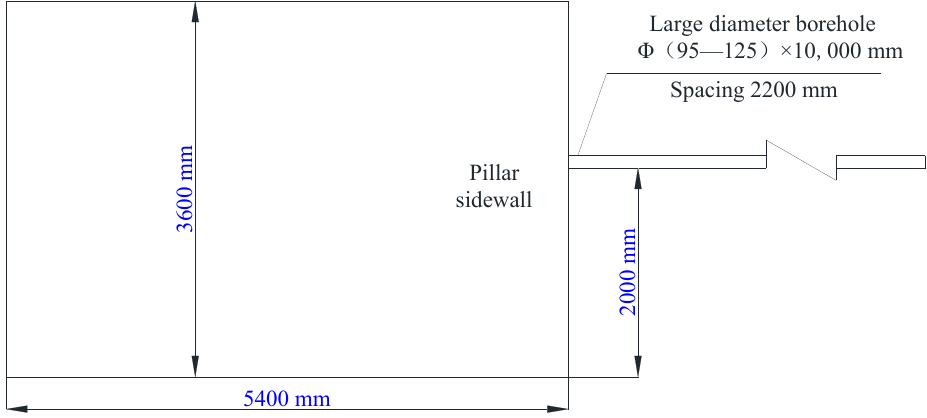
Figure 18. Large ‐ diameter borehole layout (net section). Figure 18. Large-diameter borehole layout (net